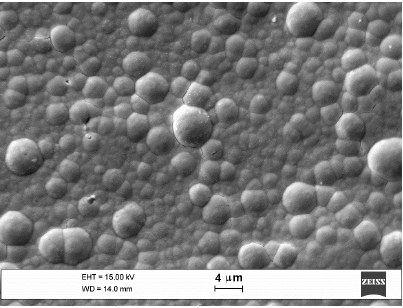
Figure 2. SEM images of Cr-coating obtained from the chromium bath with the basic composition thickness of deposits 20 µ m current density 20 A dm -2 ; temperature 35 ° C; pH 1.5